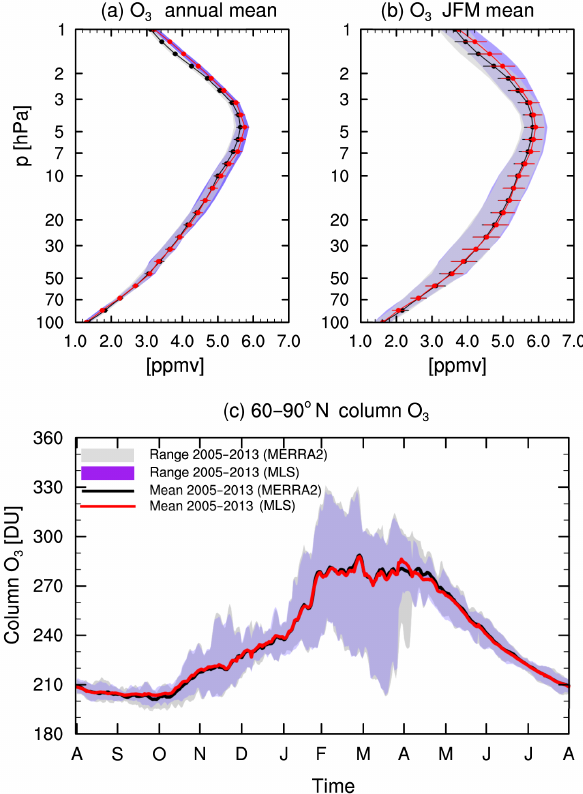
Figure A1. (a, b) Vertical profile of zonal mean ozone (ppmv) from MERRA2 and AURA MLS averaged between 60 and 90 ◦ N for (left panel) annual and (right panel) winter JFM means. (c) Daily clima- tology of total column Arctic ozone (vertically integrated from 100 to 1hPa) in Dobson units (DU). The solid black (red) curve denotes the climatological mean of MERRA2 (AURA MLS) ozone, and the gray (purple) shading indicates the range from MERRA2 (AURA- MLS) for the 2005–2013 time